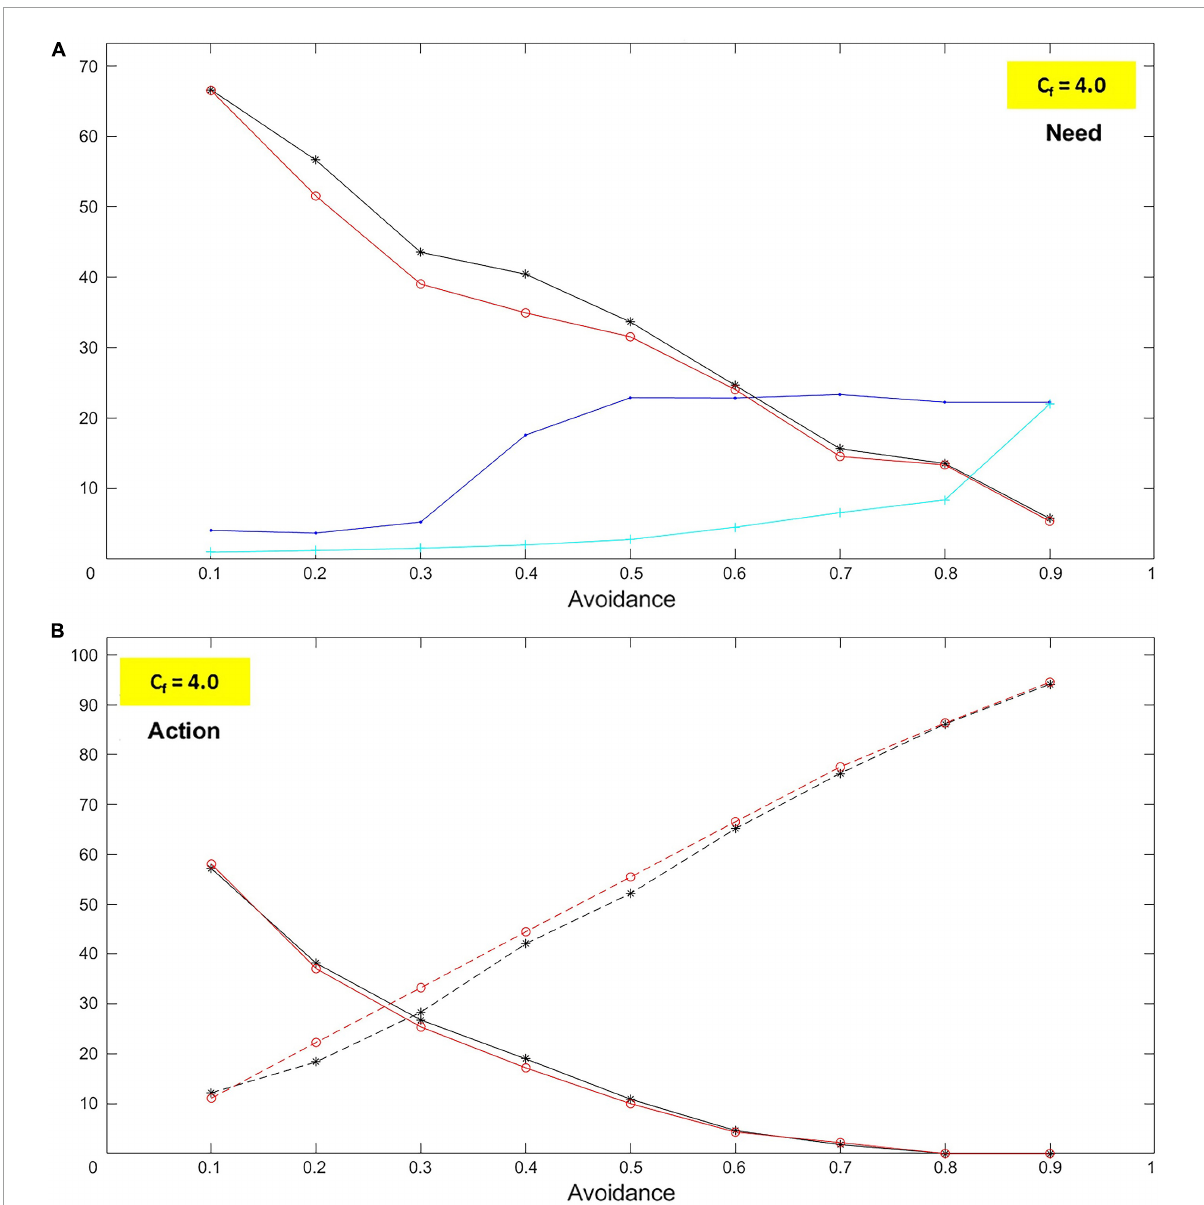
FIGURE14 More accurate avoidant implementation. When variable c 0 a , av and c 0 c , av are considered, simulation performance improves in terms of (A) needs and (B) action (approaches and